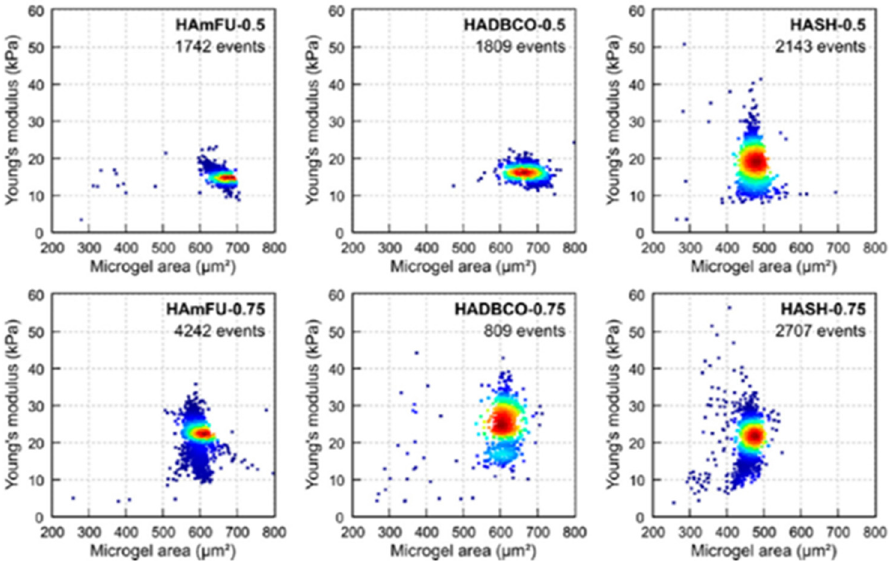
Figure 2. Scatter plots of mechanical properties of various hyaluronic acid derivative microgels determined by RT-DC. The intensity maps of Young’s modulus versus cross-sectional area of the microgels are shown for three different types of HA derivative microgels, each at two concentrations of PEG-based crosslinker. The RT-DC characterization was reported for characterization of in a microfluidic channel with 40 × 40 µm 2 cross-section and 300 µm long using a flow rate of 0.60 µL s − 1 [18].